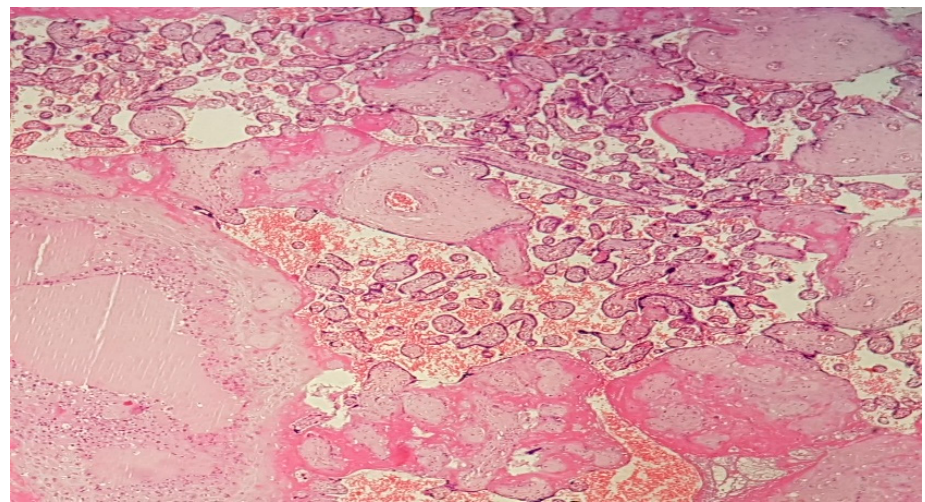
Figure 4. (Haematoxylin–eosin 10×). Decidual marked dystrophic and ischemic changes secondary to focal hypertrophic type arteriopathy; important perivillous noninflammatory fibrin deposits with encasement of necrotic and ghostlike chorionic villi; intervillous extravasated maternal blood.